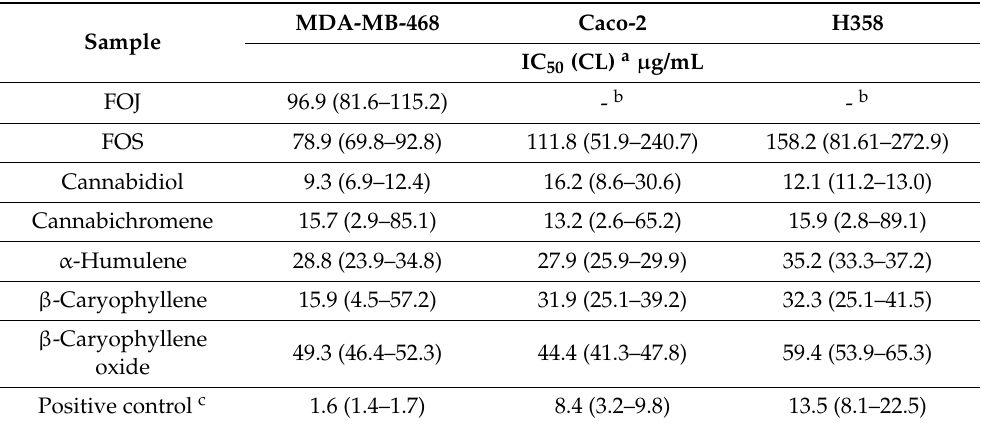
Table 2. Half maximal inhibitory concentration (IC 50 ) values of the organic extracts from the inflores- cences of Cannabis sativa var. Felina 32 collected in June (FOJ) and September (FOS), nonintoxicating phytocannabinoids, caryophyllane sesquiterpenes, and the positive control doxorubicin in human MDA-MB-468 triple negative breast cancer, Caco-2 epithelial colorectal adenocarcinoma and H358 broncho alveolar carcinoma cells after 24 h